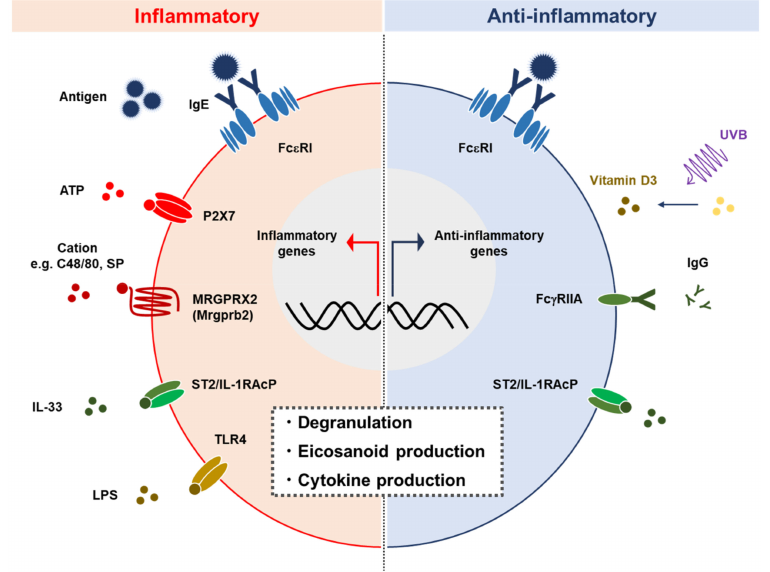
Figure 2. MCs play proinflammatory and anti-inflammatory roles. MCs are activated by various stimuli such as IgE crosslink, ATP, cations, IL-33, and LPS, via Fc ε RI, P2X7, MRGPRX2 (Mrgprb2), IL-33R, and TLR4, respectively. MC activation is followed by degranulation and the release of cytokines and eicosanoids. MCs also exhibit anti-inflammatory function including the production of IL-10 in certain circumstances [70,76]. SP: Substance P.